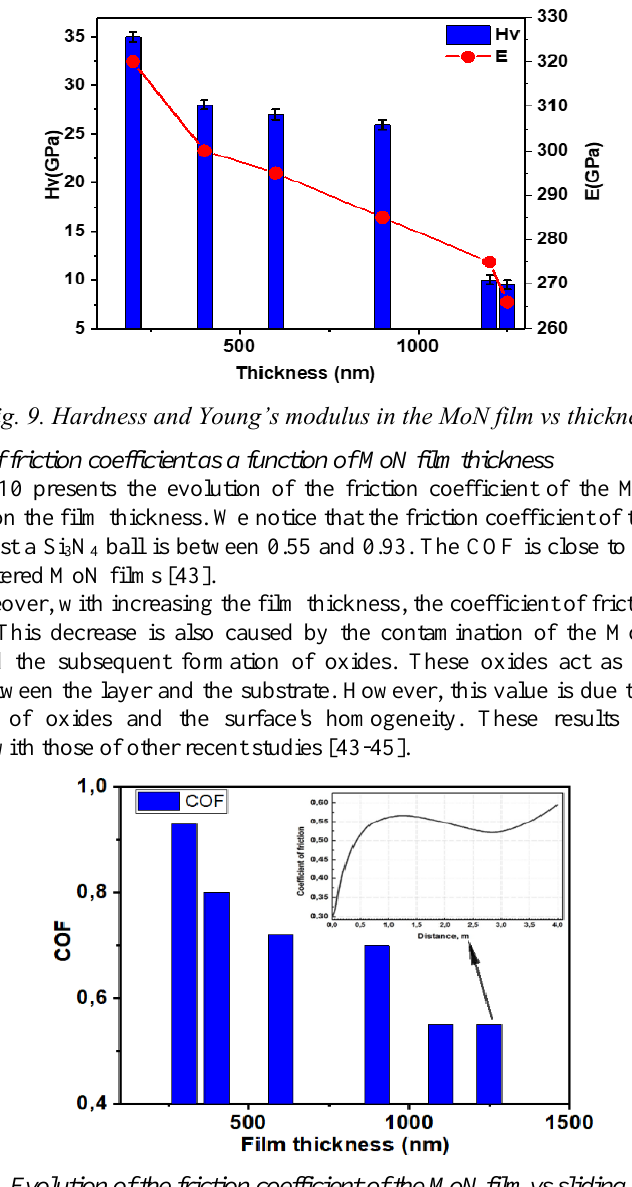
Fig. 10. Evolution of the friction coefficient of the MoN film vs sliding